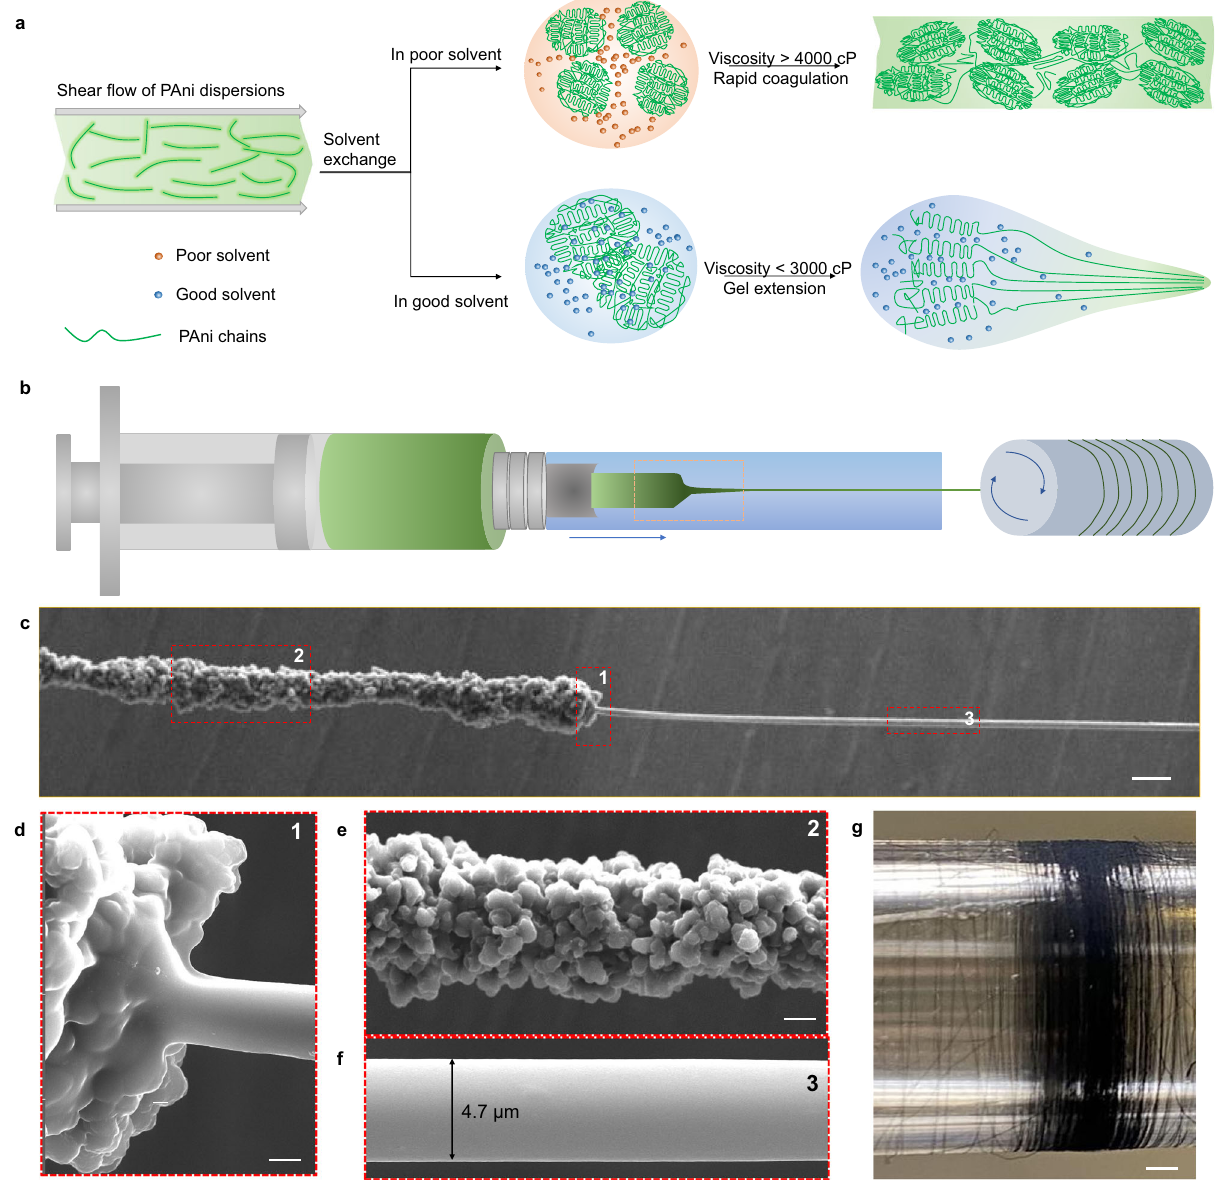
Fig. 1 Scalable production of UFPFs. a Schematic of the good solvent exchange strategy to prepare UFPFs in a modi fi ed wet spinning protocol. In the case of poor solvent exchange (light orange region, upper panel), PAni molecules are rapidly solidi fi ed into thick gels and proto fi bres with rough crystallized particles. In the case of good solvent exchange (light blue region, lower panel), the formed gels with low viscosity occur an impressive gel extension and are slenderized into ultra fi ne fi bers. b Schematic of the modi fi ed wet spinning process. c Scanning electron microscope (SEM) image of the marked region in ( b ), showing the sharp necking behavior of gel PAni fi bers. The close observation of region 1 ( d ), region 2 ( e ), and region 3 ( f ) in the marked zone of ( c ), illustrating the sharply necking process of PAni gels. g Photograph of a 5.4-kilometers-long UFPF collected in two hours. Scale bars: c 20 µ m, d 2 µ m, e 10 µ m, g 150